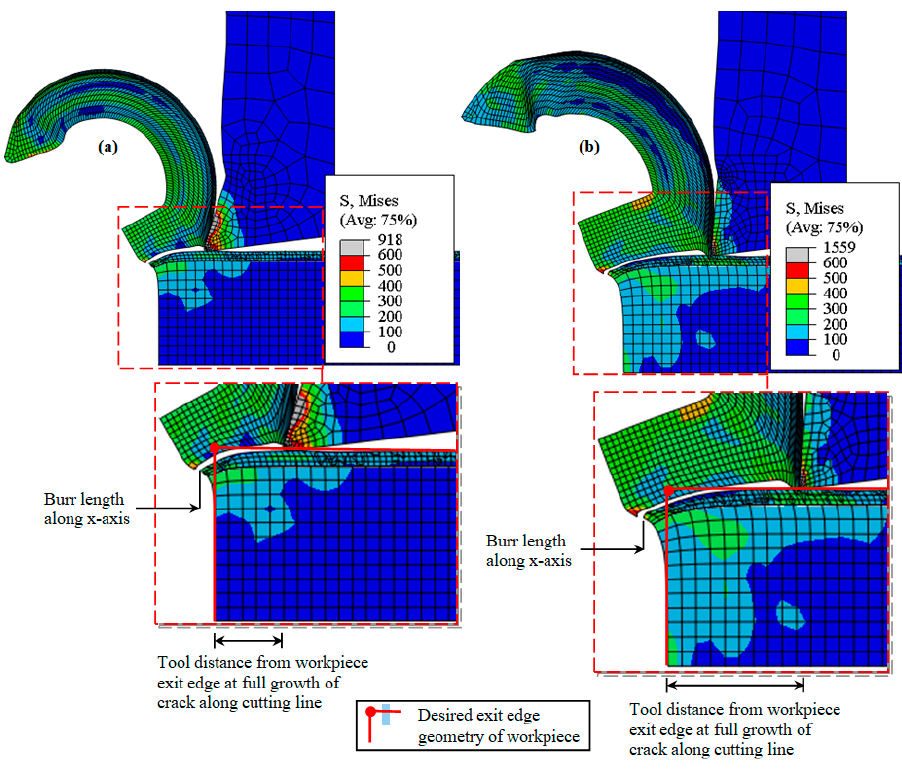
Figure 5. Boot type chip and end burr formation at Z = 0 ( a ) V C = 1000 m/min, f = 0.3 mm/rev, γ = 17.5 ◦ ( b ) V C = 800 m/min, f = 0.4 mm/rev, γ = 5 ◦ .